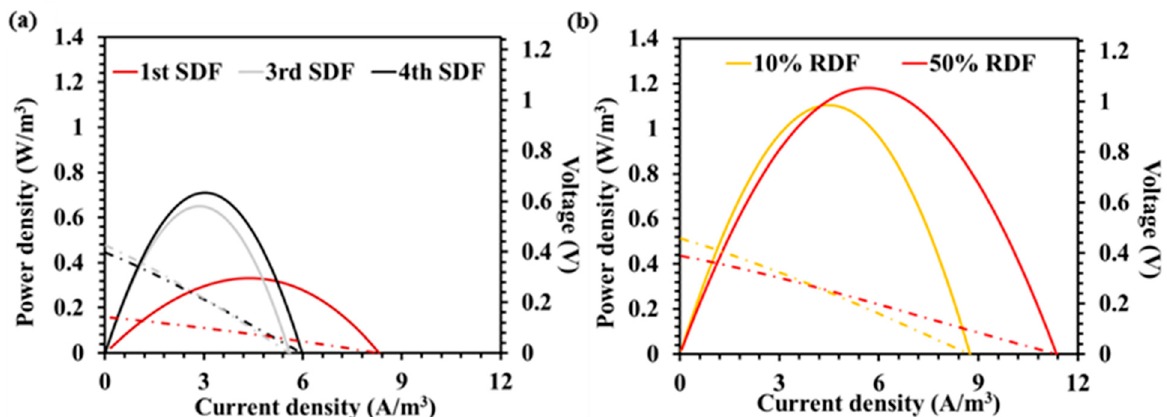
Figure 7. Electric power density (solid lines) and voltage (dashed lines) versus the current density for ( a ) three SDF cycles (1st, 3rd, and 4th) and ( b ) RDF as feeds to the MFC.